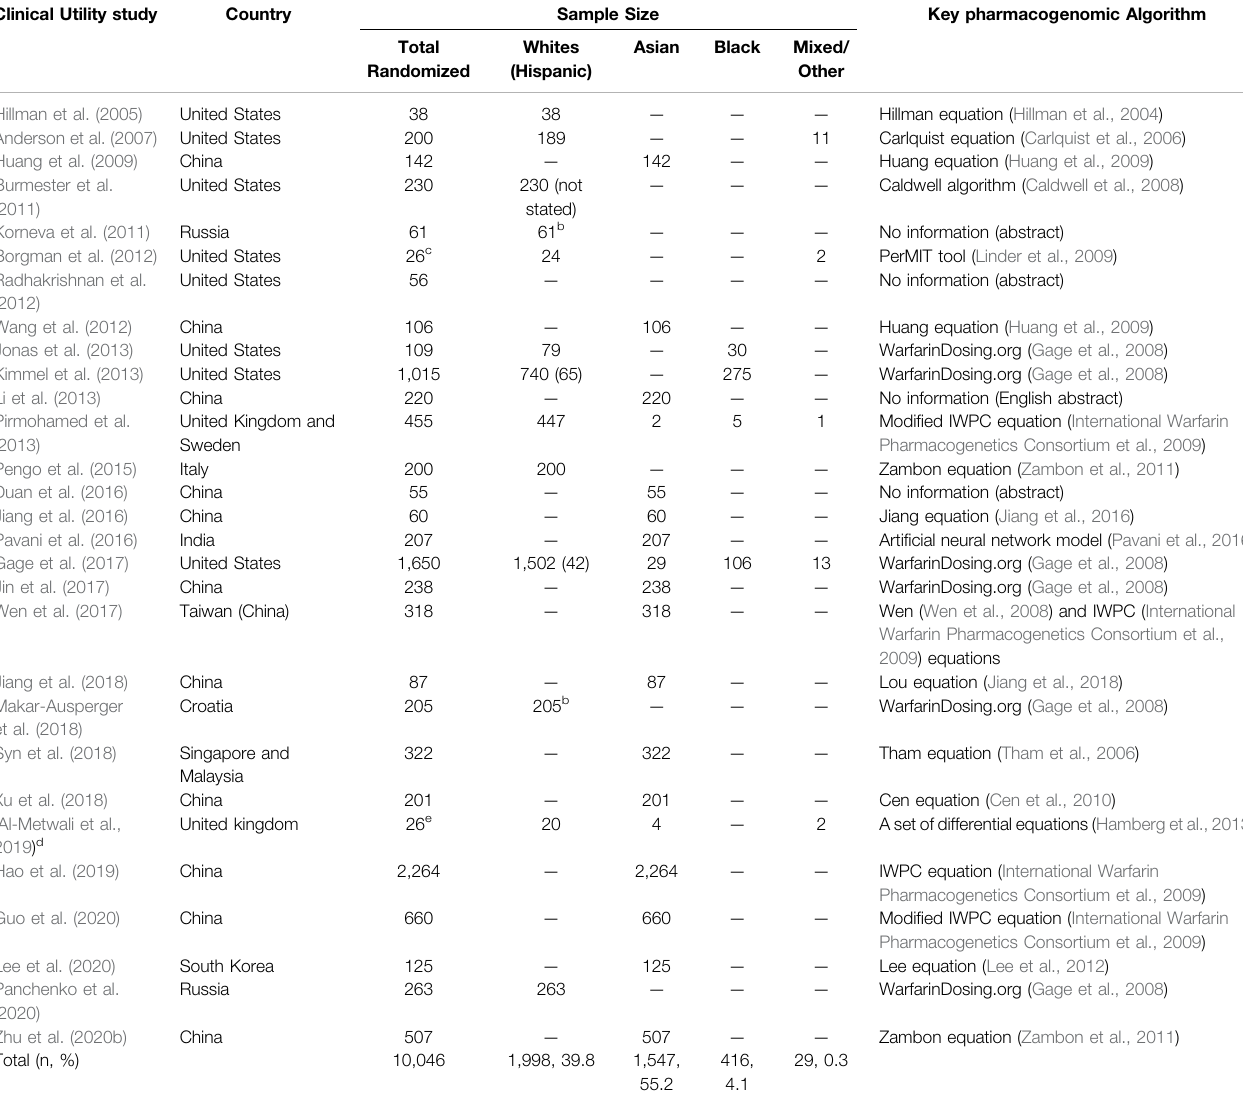
TABLE 2 | Randomized control trials a assessing clinical utility, as of July 2021 (Asiimwe et al., 2021; Wang et al., 2022). Clinical Utility study Country Sample Size Key pharmacogenomic Algorithm